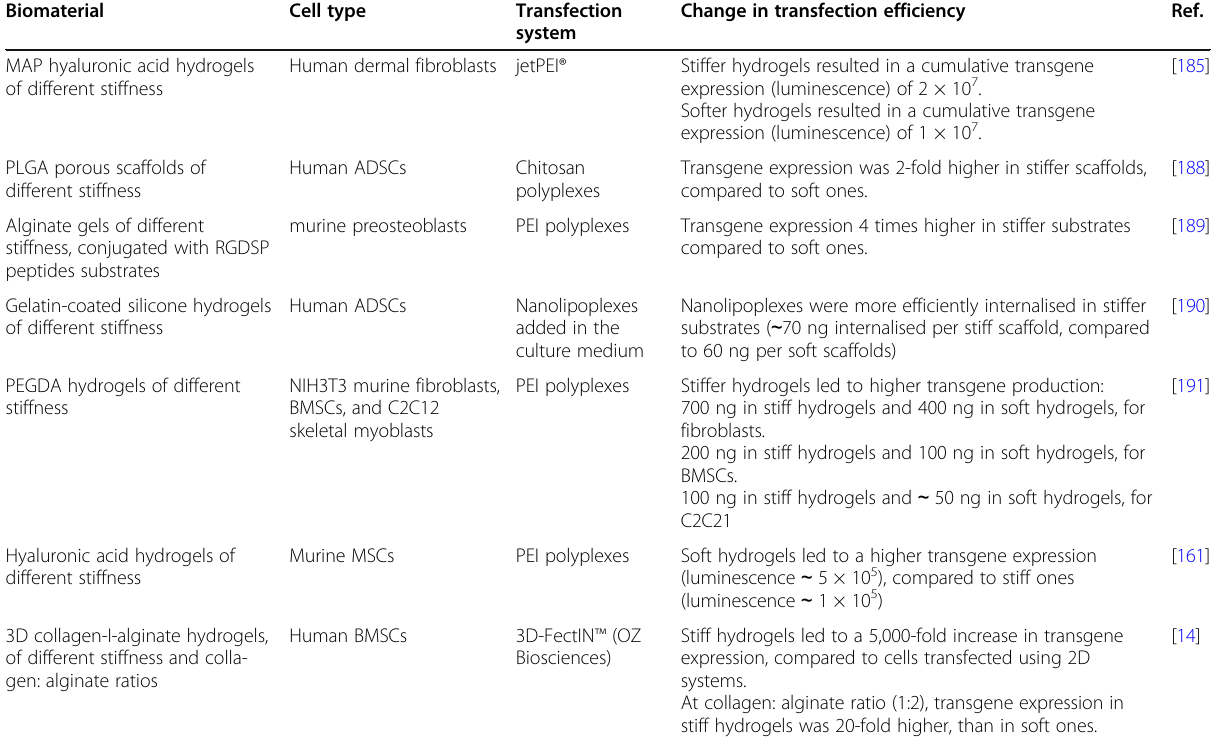
Table 4 Biomaterial stiffness and gene delivery. Research papers assessing the effect of biomaterial stiffness on non-viral-mediated gene